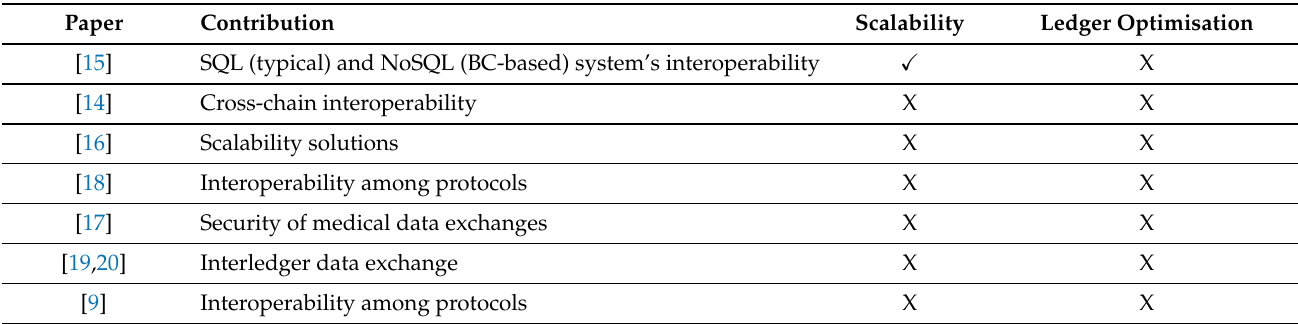
Table 1. Related contributions